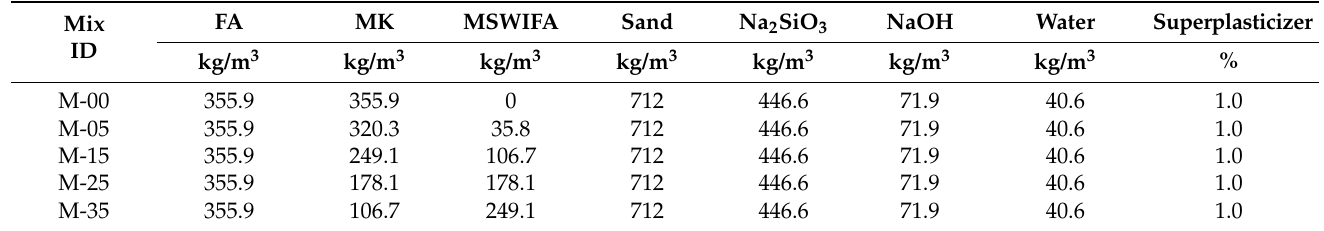
Table 2. The mix proportions of the geopolymer